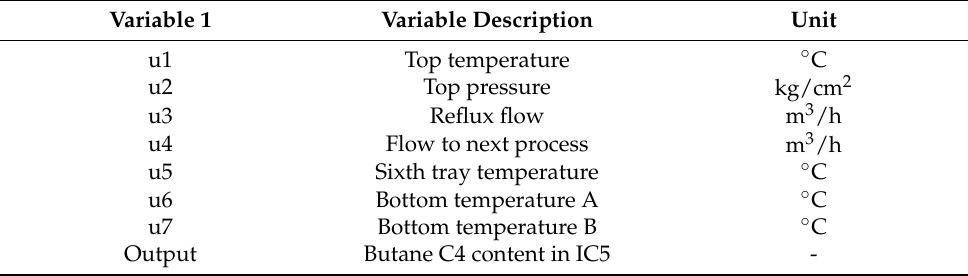
Table 1. Description of debutanizer column process